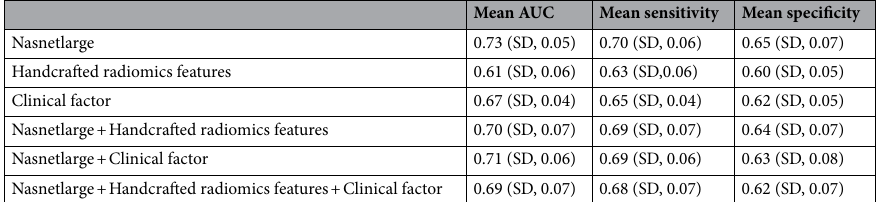
Table 2. Mean 0.632 + bootstrap AUCs, sensitivity, and specificity of the deep learning-based radiomics, handcrafted radiomics features, clinical factors, and combined models for predicting nodal gross tumor volume (GTVn) regression. AUC area under the curve, SD standard